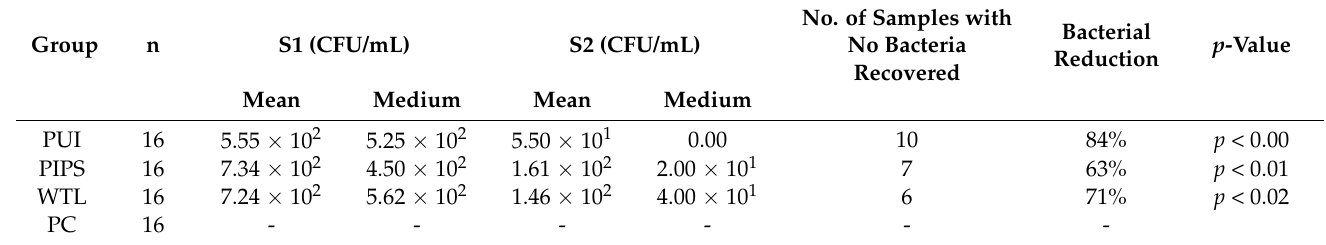
Figure 1. Bar chart illustrating the number of samples with negative bacterial cultures using paper- point and pulverisation sampling methods after final rinsing with different irrigation protocols. Table 2. Colony-forming units (CFU) of E faecalis recovered at the apical 5 mm of the root canal using the pulverisation sampling method.